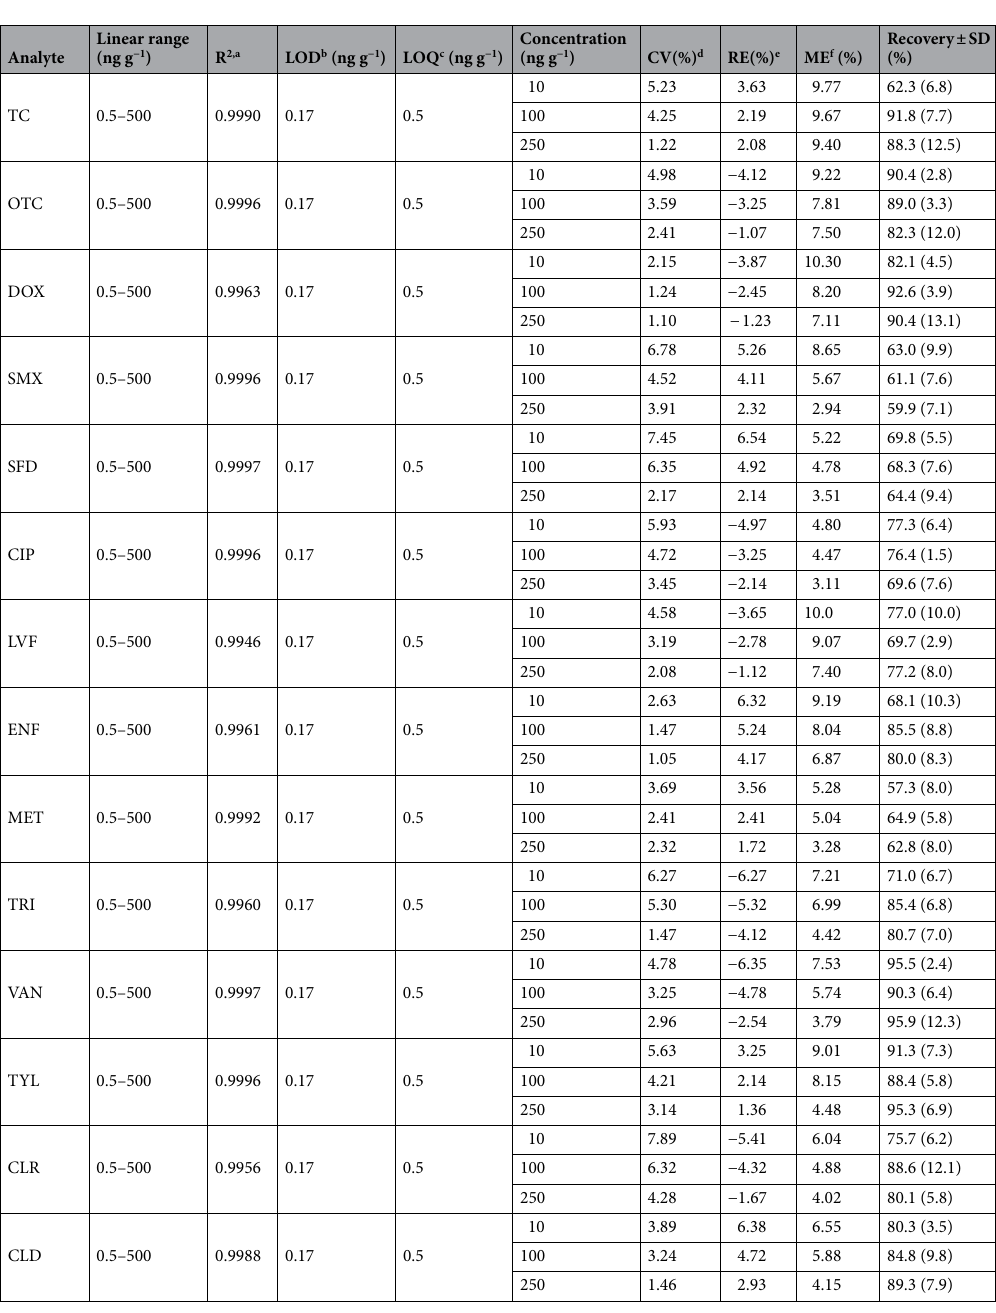
Table 2. The analytical method parameters and extraction recovery of antimicrobials in soil samples at three concentrations ( n = 6). a R 2 —coefficient of determination. b LOD—limit of detection. c LOQ—limit